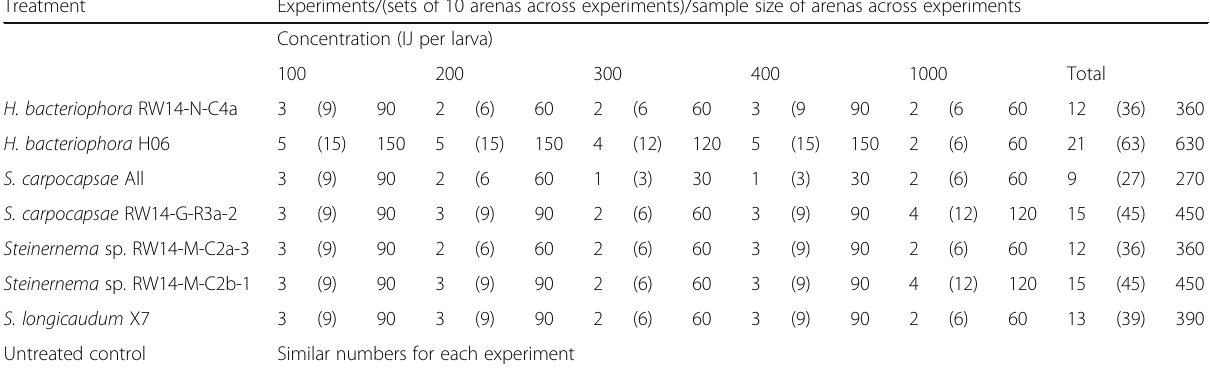
Table 2 Experimental replicates, sets of bioassay arenas, and total sample sizes of arenas per tested entomopathogenic nematode and applied concentration in soil-based laboratory bioassays (concentration = 100, 200, 300, 400 and/or 1000 infective juveniles (IJs) per grub equalling 4, 8, 12, 16 and 40 IJs per gram soil, 2.4, 4.8, 7.1 and 9.5 IJs per cm 3 soil and 14, 28, 42, 57, and 140 IJs per cm 2 soil surface). An experiment consisted of at least two sets of 10 bioassay arenas each, and each arena containing one Anomala graueri grub Treatment Experiments/(sets of 10 arenas across experiments)/sample size of arenas across